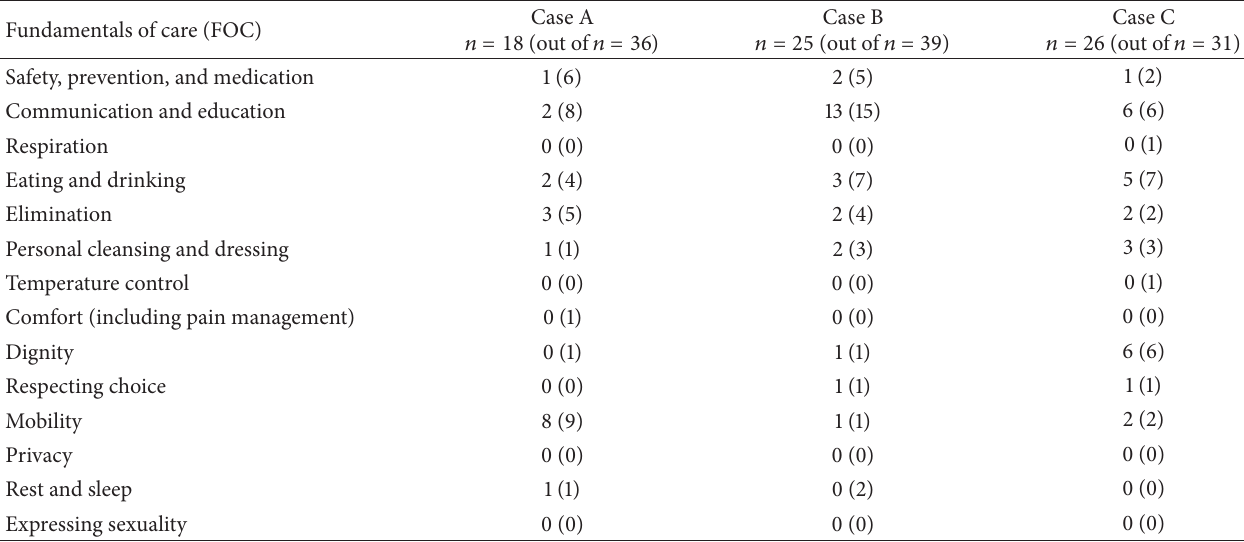
Table 3: Number of care episodes describing interactions with staff identified in text coded according to the fundamentals of care template: three